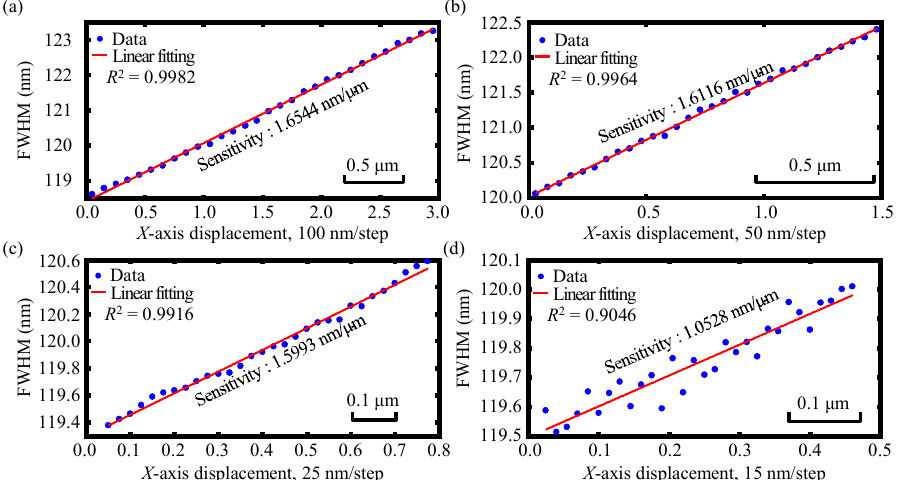
Figure 10. Experimental results of the X -axis displacement resolution of the established chromatic dispersion probe with different moving steps of ( a ) 100 nm, ( b ) 50 nm, ( c ) 25 nm, and ( d ) 15 nm, respectively.